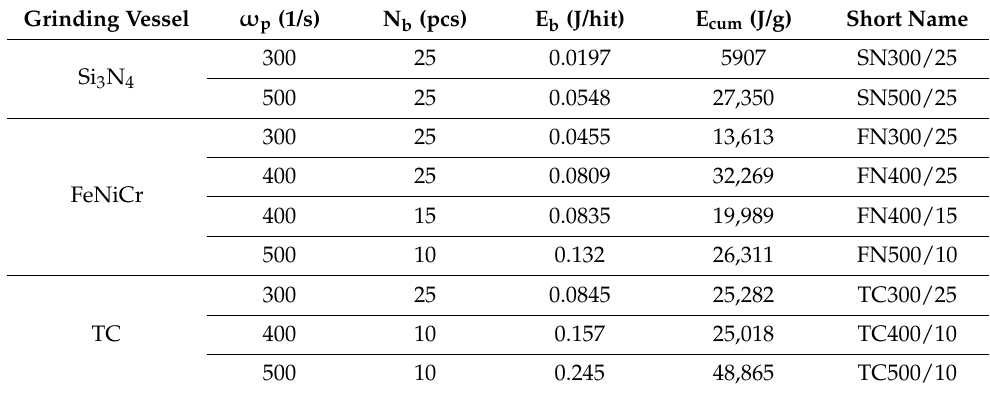
Table 1. Values of E cum and E b for each grinding vessel. ω p : rotational speed of the grinding vessel. N b : number of grinding balls.